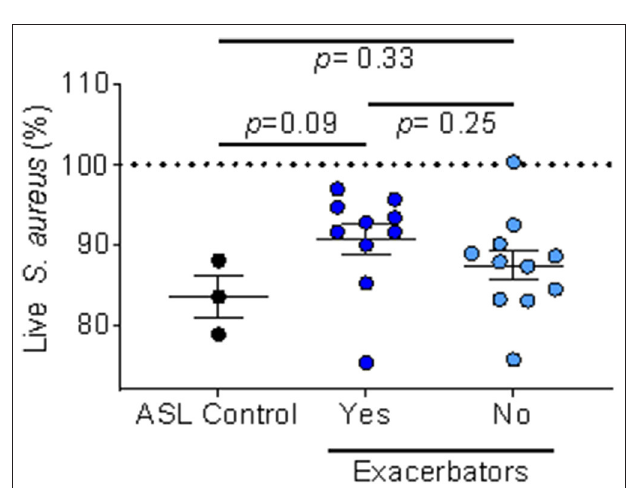
FIGURE 5 | IAP’s effect on ASL antimicrobial activity based on exacerbation history. Percent of live S. aureus at 16min in the presence of IAP from exacerbators vs. non-exacerbators—values greater than the ASL control indicate inhibition of bacterial killing, while values lower than ASL alone indicate increased bacterial killing. Error bars represent means and standard error of the means. To test for differences between ASL with the field-blank control and the respiratory exacerbator group (and non-exacerbator group) we used unpaired t